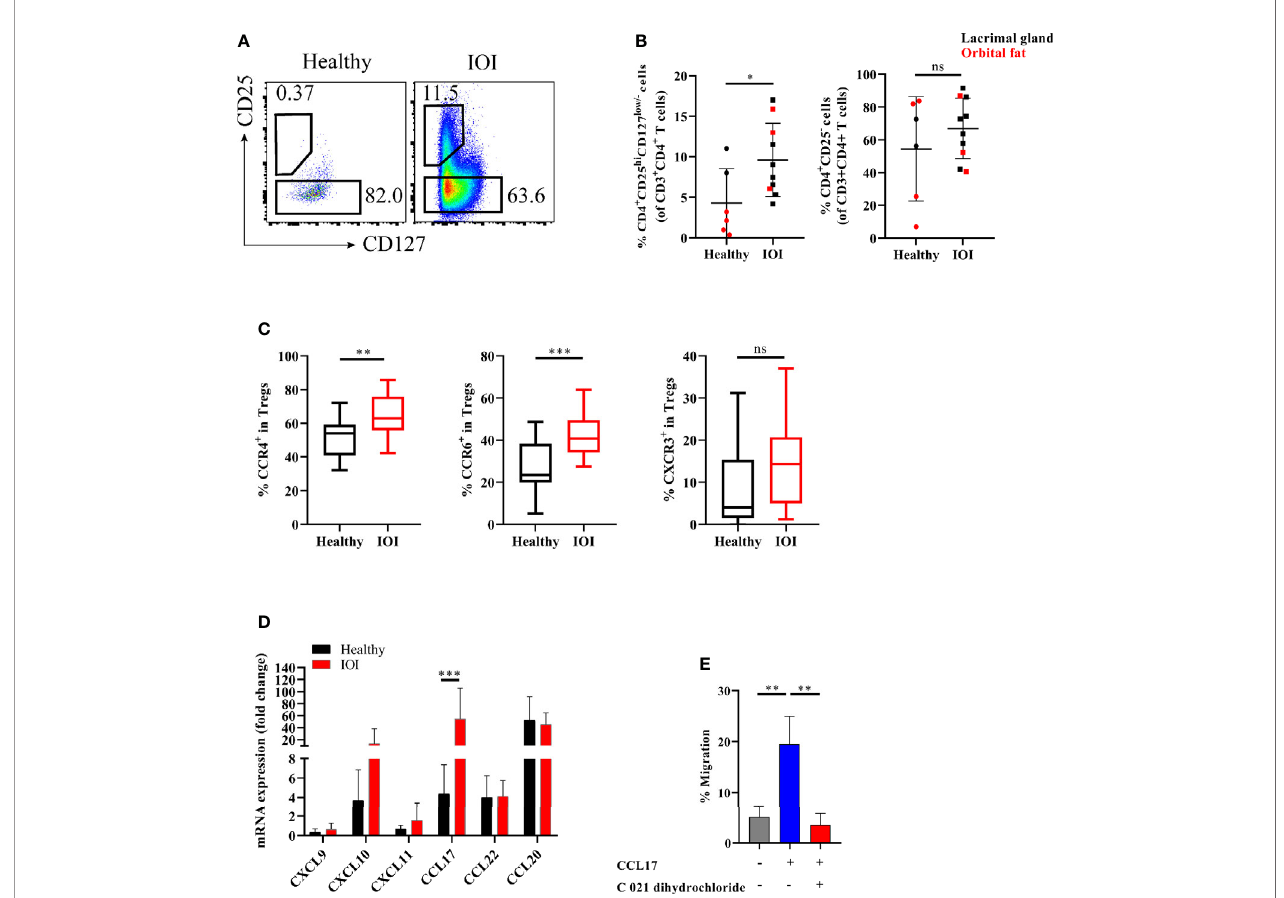
FIGURE 2 | Expanded orbit-derived regulatory T cells (Tregs) in patients with idiopathic orbital in fl ammation (IOI). The frequency of orbit-in fi ltrating Tregs was analyzed by fl ow cytometry. (A, B) Frequency of orbit-in fi ltrating Tregs in patients with IOI (n=10) and healthy controls (n=6). (C) The proportions of CCR6 + Tregs, CCR4 + Tregs and CXCR3 + Tregs in blood were calculated. (D) CXCL9, CXCL10, CXCL11, CCL17, CCL20 and CCL22 mRNA expression in orbital fat from healthy controls and patients with IOI. (E) Migration of Tregs cultured in the presence of CCL17 or pretreated with CCR4 antagonist (C 021 dihydrochloride). * P < 0.05; ** P < 0.01; *** P < 0.001; ns, not signi fi